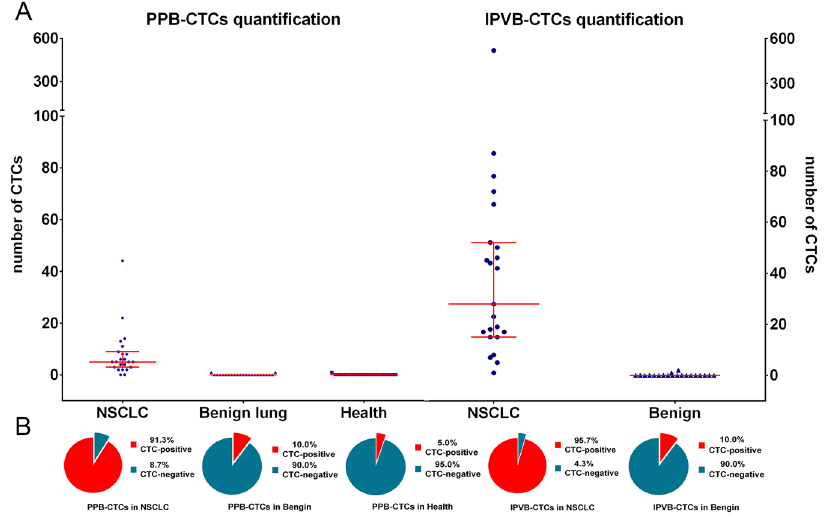
Figure 1. Analysis of circulating tumor cells in different groups. ( A ) Scatter plots showing the number of CTCs in different groups drawn using blue points, and the median and interquartile range are indicated by red lines. ( B ) Pie chart showing the ratio of CTC-positive and CTC-negative patients in different groups. Abbreviations: * CTCs: circulating tumor cells; PPB: preoperative peripheral blood; IPVB: intraoperative pulmonary venous blood; NSCLC: non-small cell lung cancer; Benign: benign lung disease group; Health: health volunteers